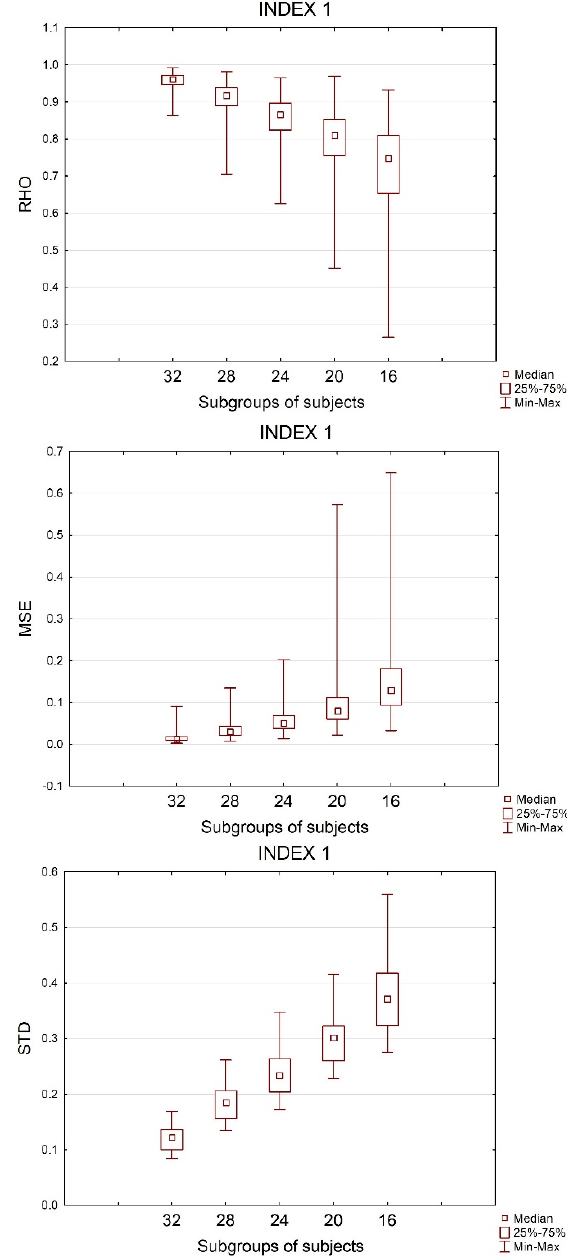
Figure 2. The box plots represent the effect of the subgroup of subjects on ( a ) Rho values, ( b ) MSE values, and ( c ) STD values, computed for Index 1, during the SPOT 1.